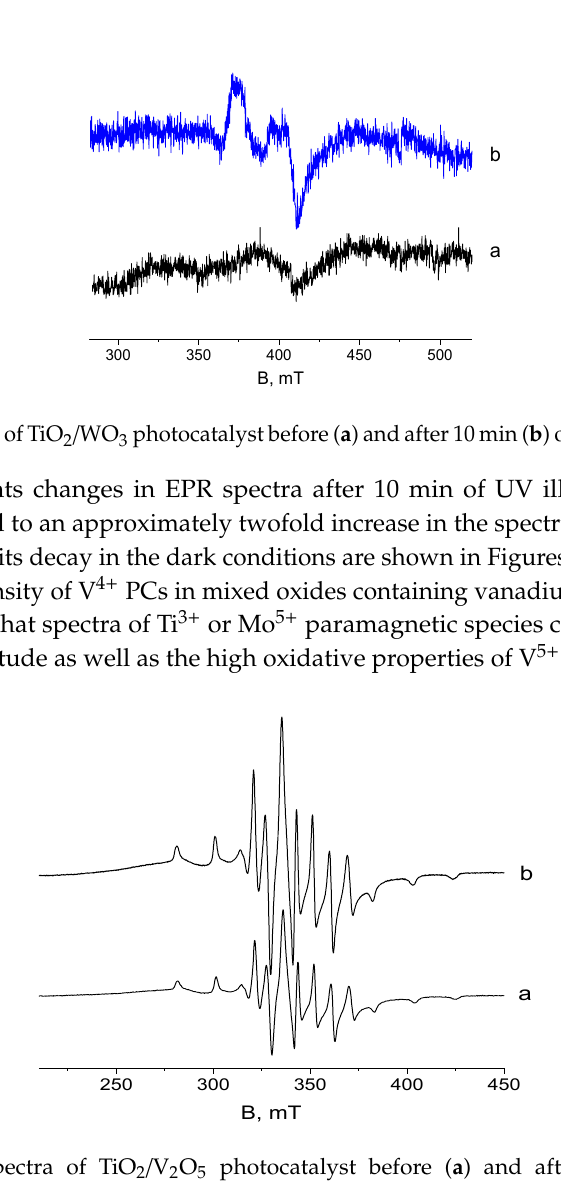
Figure 10. EPR spectra of TiO 2 /V 2 O 5 photocatalyst before ( a ) and after 10 min ( b ) of UV light illumination.